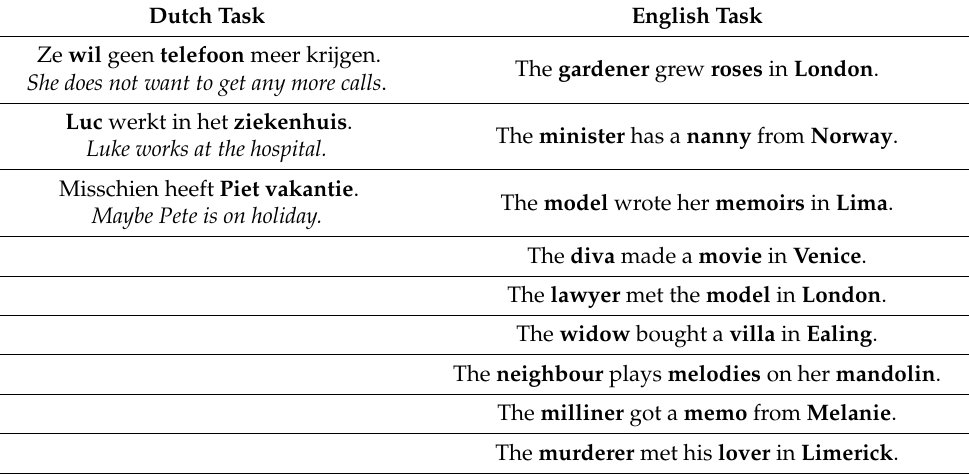
Table 3. Focus sentences used in each experiment.